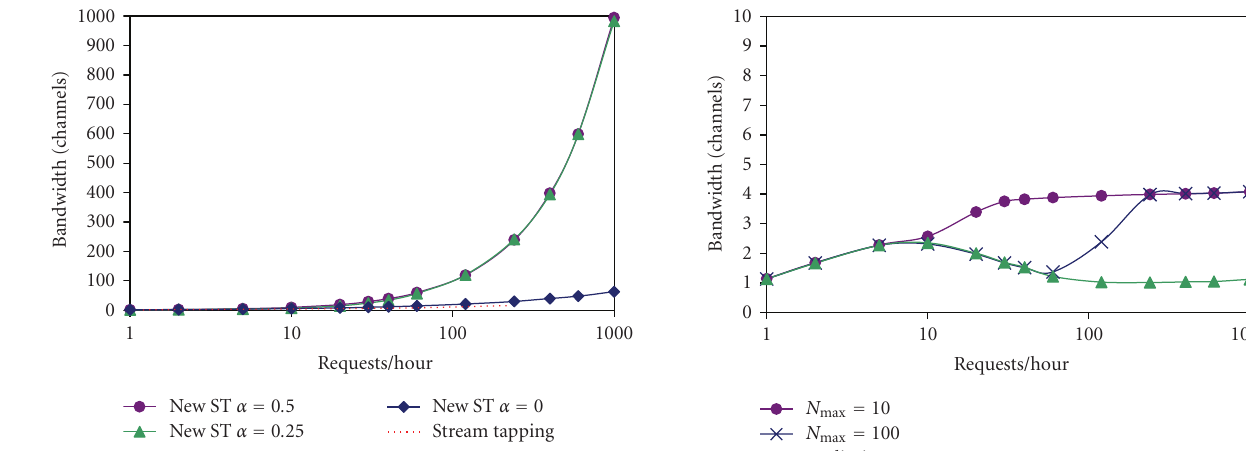
Figure 6: Server bandwidth requirements of the protocol for α = 0.25, and β max = 0.25.